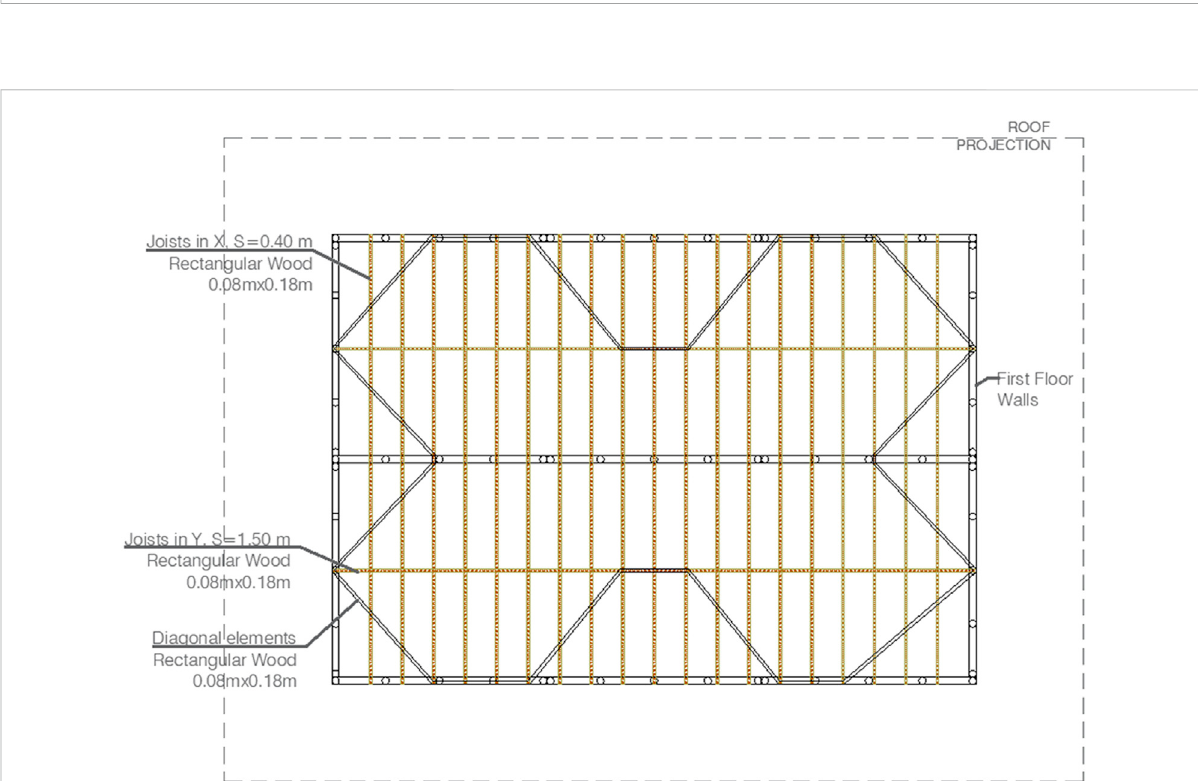
FIGURE 8 Mezzanine Diaphragm Model. Design inspired by the publication by López-Muñoz (2015).